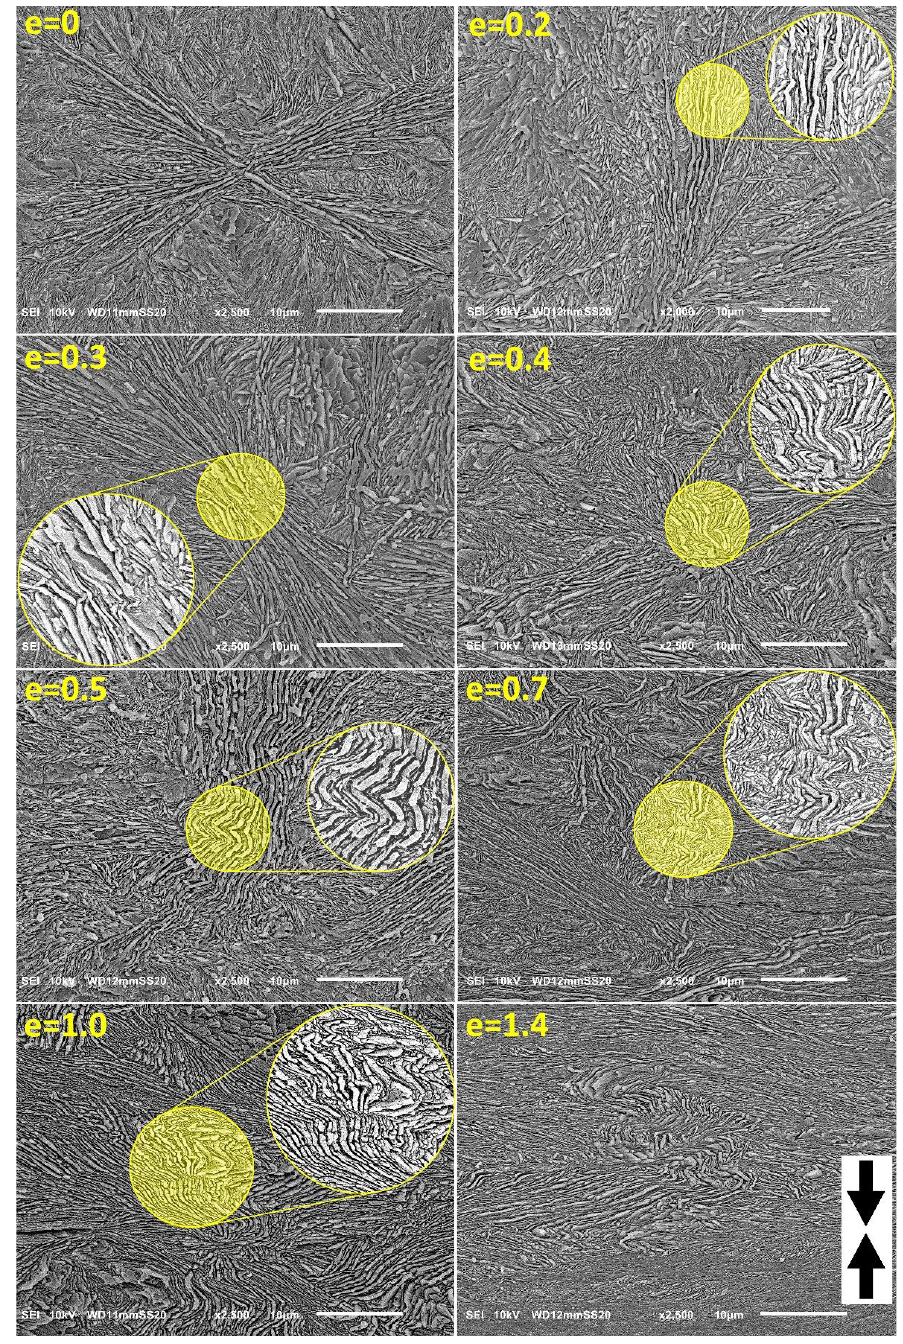
Figure 5. SEM micrographs of the H3-CE samples deformed by uniaxial compression to the true strain indicated. The direction of compression is vertical. The observation plane was exposed by microtoming followed by permanganic etching. Circular insets show enlarged details.